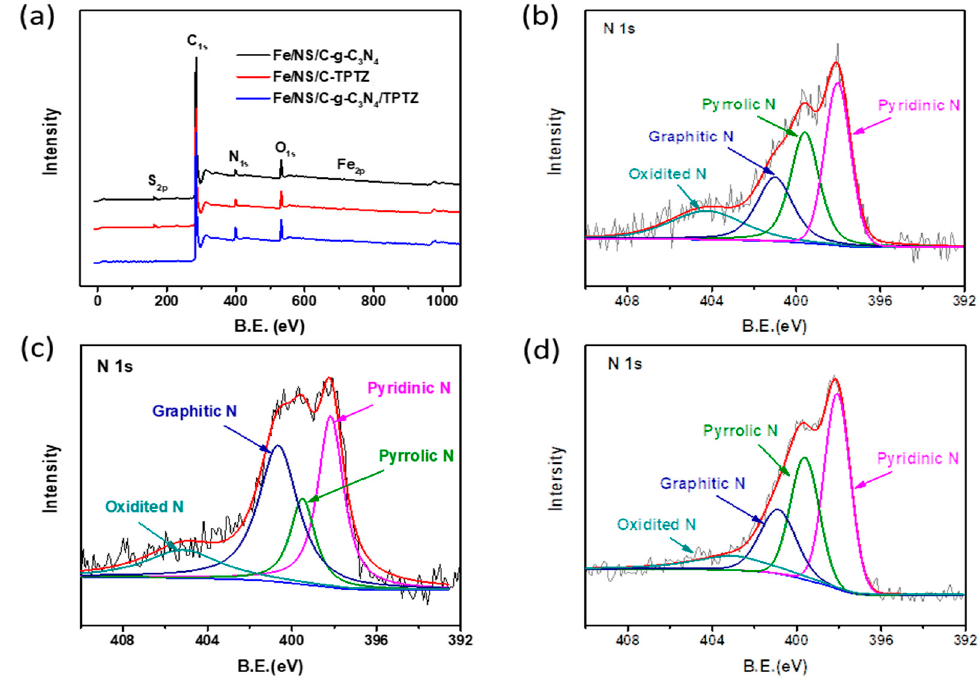
Figure 2. ( a ) X ‐ ray photoelectron spectroscopy (XPS) survey spectra of Fe/NS/C ‐ g ‐ C 3 N 4 , Fe/NS/C ‐ TPTZ, and Fe/NS/C ‐ g ‐ C 3 N 4 /TPTZ catalysts; high ‐ resolution N 1s XPS spectra of ( b ) Fe/NS/C ‐ g ‐ C 3 N 4